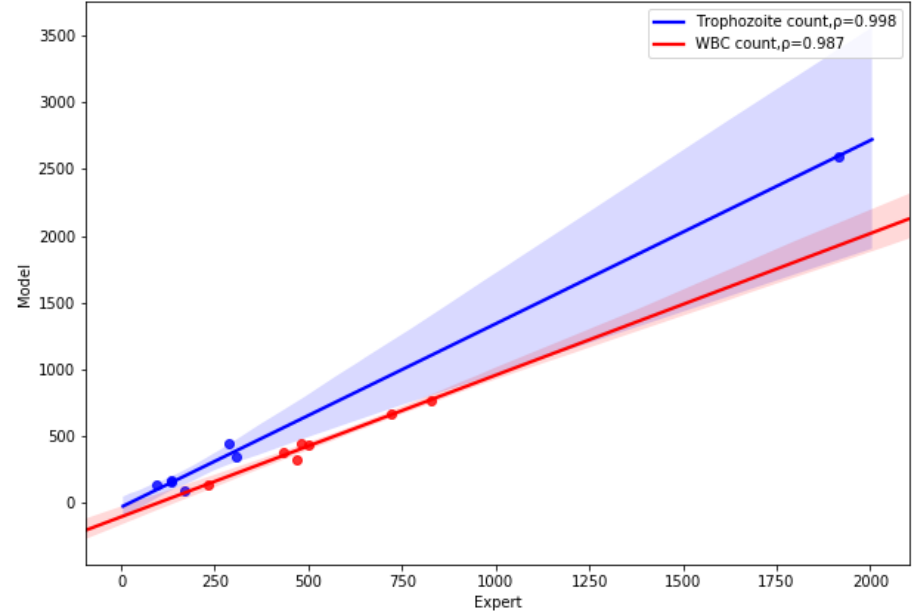
Figure 7. Correlation between model counts and manual expert counts per